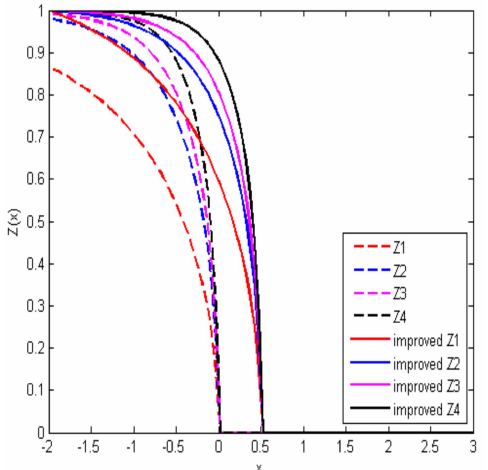
Figure 4. The original (the four dotted lines) and improved (the four solid lines) Z-shaped families of transfer